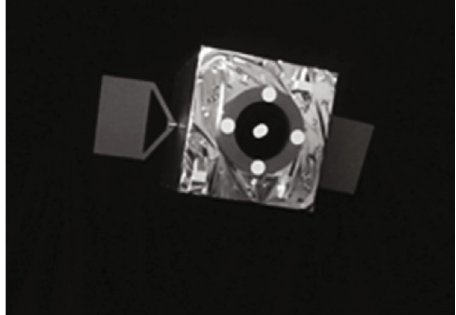
Figure 13: An image of the satellite model captured by the monocular camera.